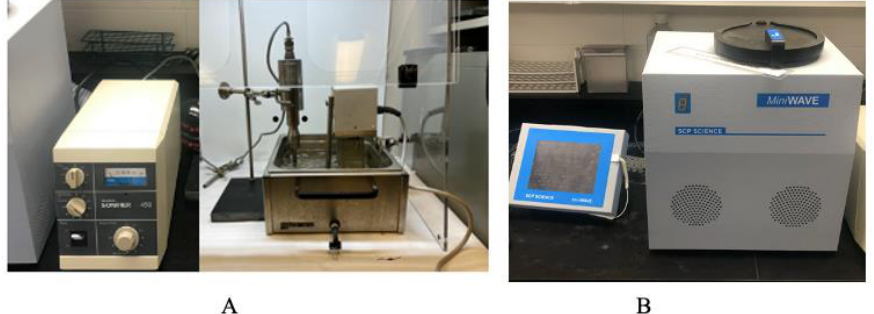
Figure 5. Branson Sonifier 450 ultrasound ( A ) and mini-wave microwave ( B ) extraction systems used for the study.